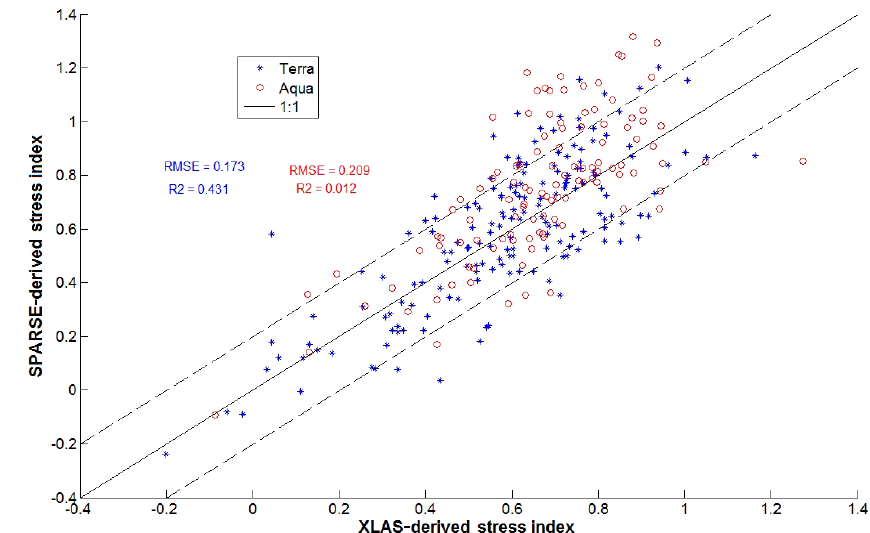
Figure 9. Modeled vs. XLAS-derived stress index SF at Terra and Aqua overpass times.